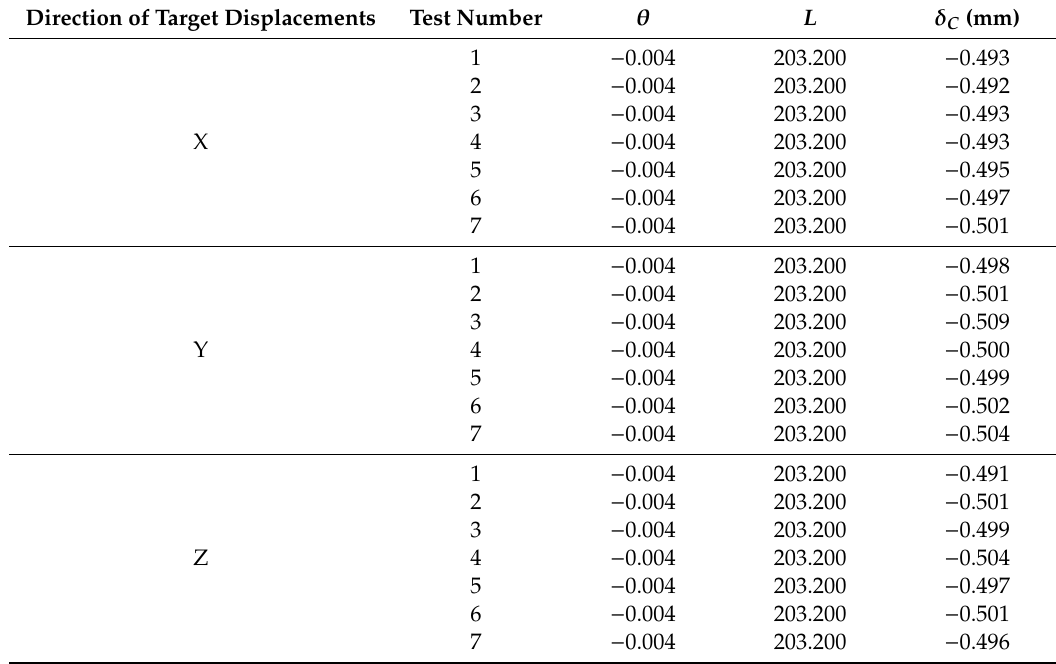
Table 3. The synchronized and averaged static camera movements at each position of the target displacements in the X, Y and Z